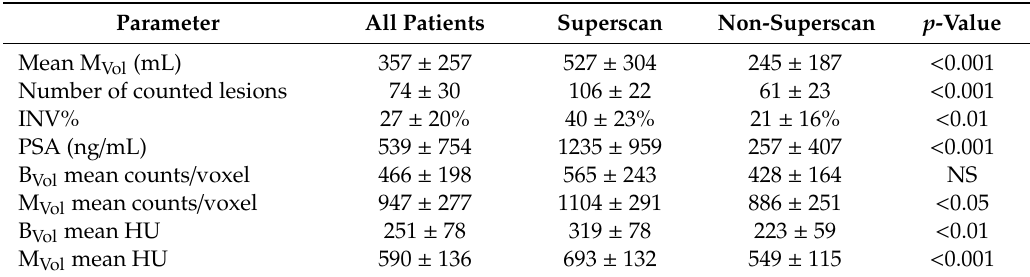
Table 1. Radiological and laboratory parameters in patients with or without superscan.